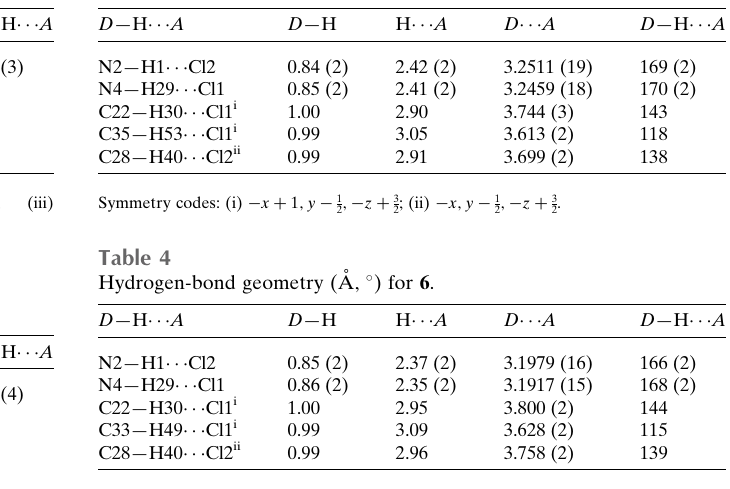
Table 3 Hydrogen-bond geometry (A˚ , (cid:5) ) for 5 .